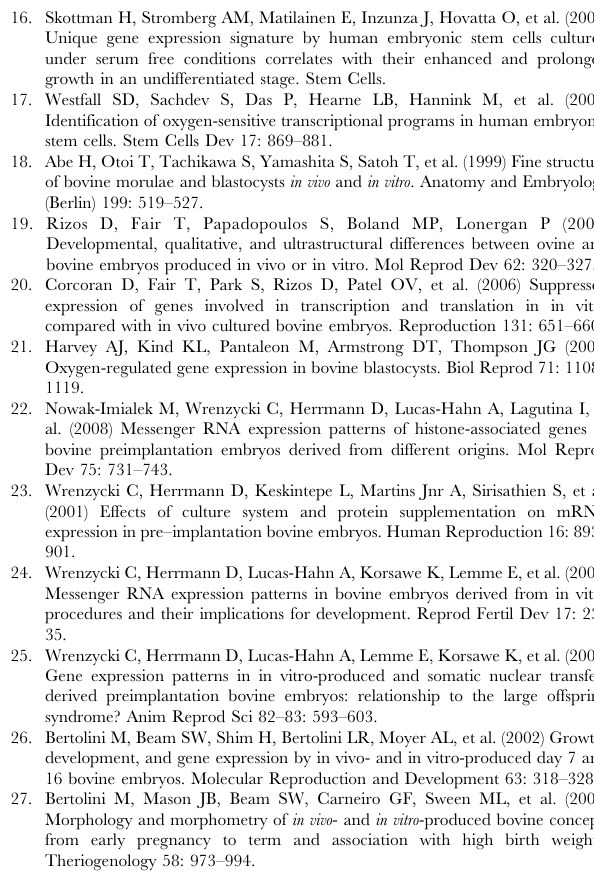
Table S1 PCR primer sequences used for validation of microarray results. Table S2 dChip output generated from CEL files (GEO: